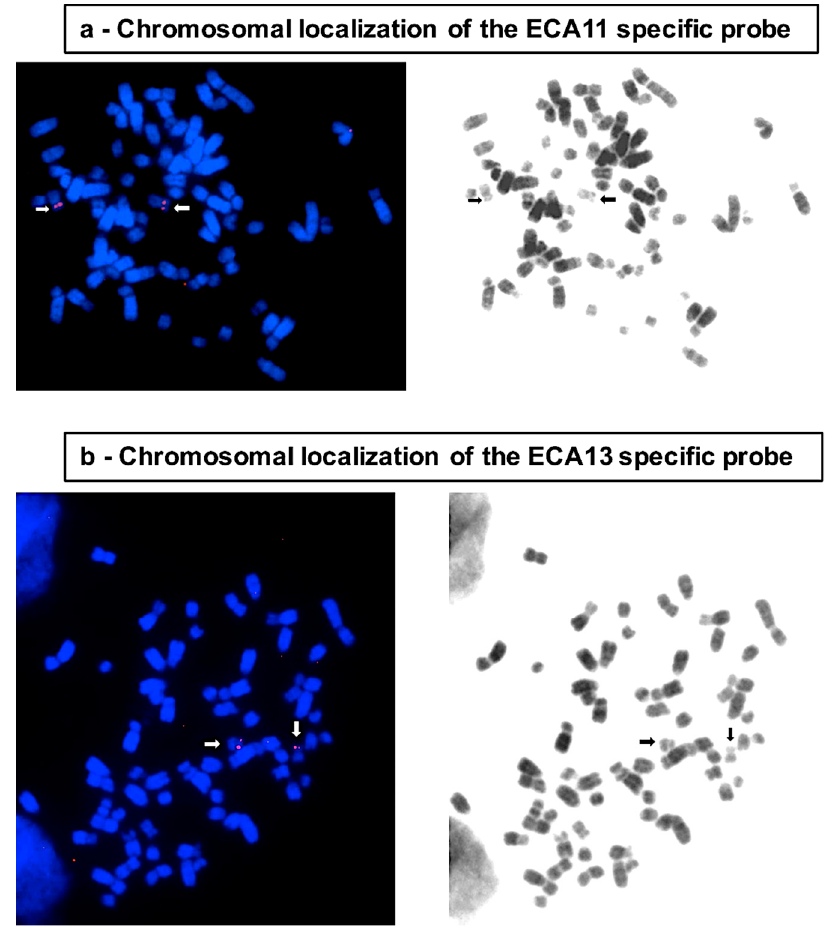
Figure 1. Chromosomal localization by fluorescence in situ hybridization (FISH) of the bacterial artificial chromosome (BAC) probes used. ( a ) FISH with the ECA11 specific BAC probe. Chromosome 11 is marked by the arrows. ( b ) FISH with the ECA13 specific BAC probe. Chromosome 13 is marked by the arrows. Probe localization is marked by the red FISH signals in the images on the left. Chromosomes are counterstained with 4', 6'-Diamidino-2-phenylindole hydrochloride (DAPI). Reverse DAPI banding is shown in the images on the right.